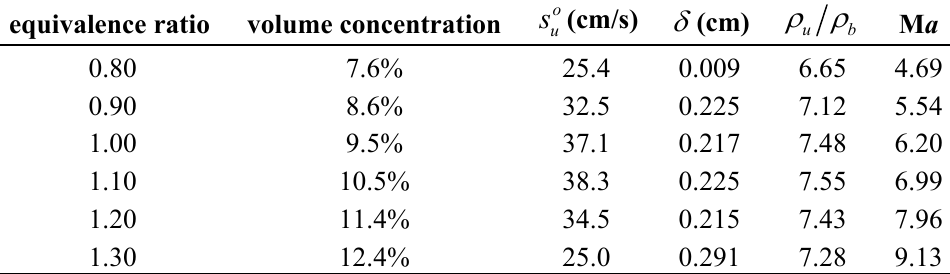
Table 1. Flame dynamic parameter from